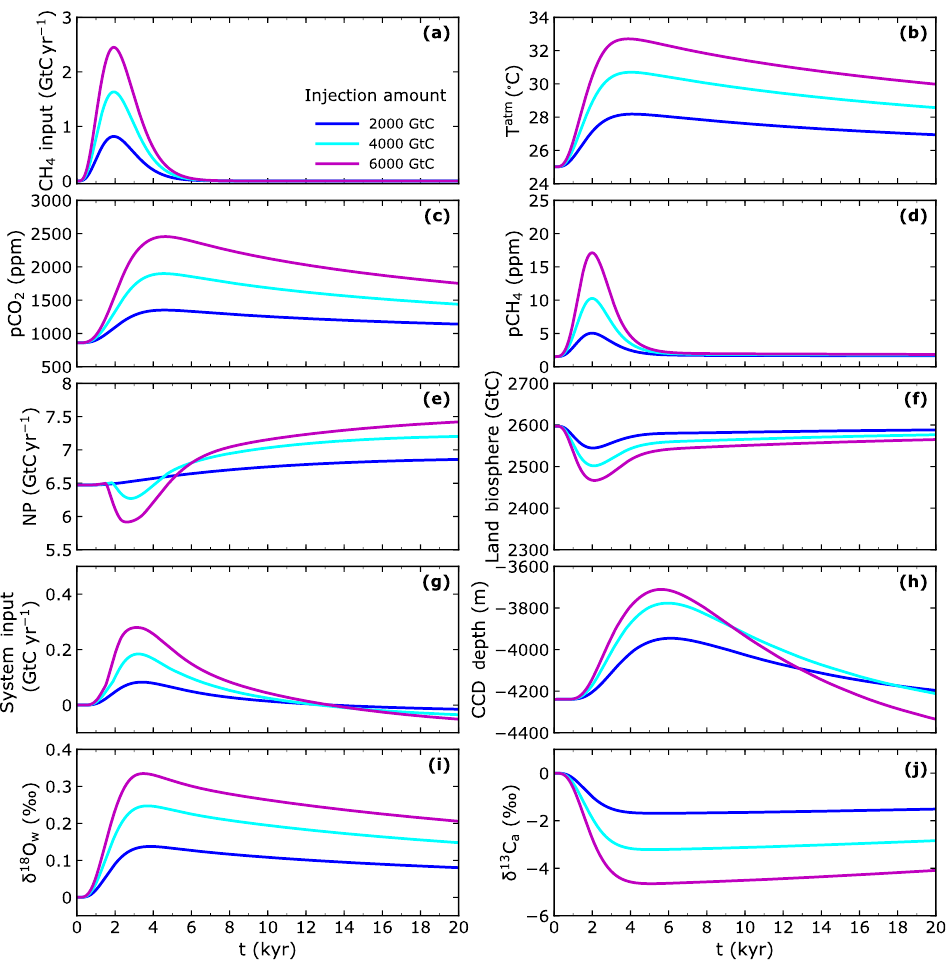
Figure 7. Results for 20000-year simulations for different methane input amounts over a timescale of 3000 years and with half the in- put dissolved in the ocean and half escaping as gas to the atmosphere. (a) methane input rate, (b) global mean atmospheric temperature, (c) atmospheric partial pressure of carbon dioxide, (d) atmospheric partial pressure of methane, (e) total ocean new production, (f) total land biosphere biomass, (g) volcanic/weathering inputs minus burial outputs (as black line in Fig. 6g), (h) LL CCD depth (10% CaCO 3 dry weight in sediment), (i) oxygen isotope excursion of LL ocean surface-layer water, and (j) atmospheric carbon isotope excursion (the methane input has δ 13 C = −